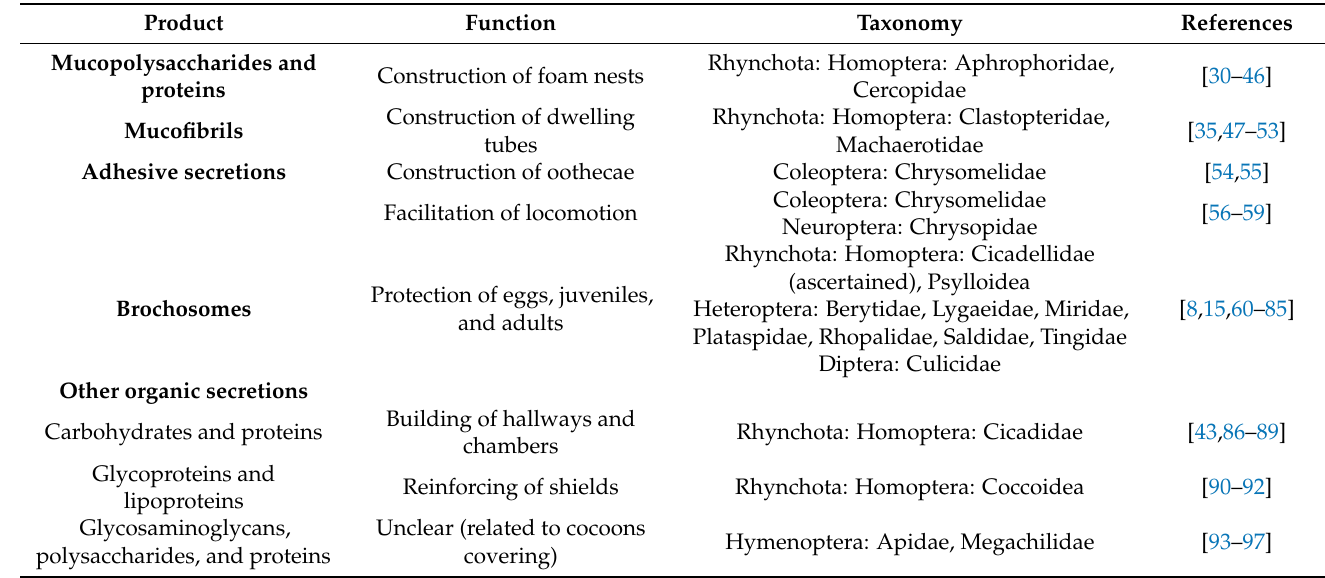
Table 1. Specialized functions related to the Malpighian